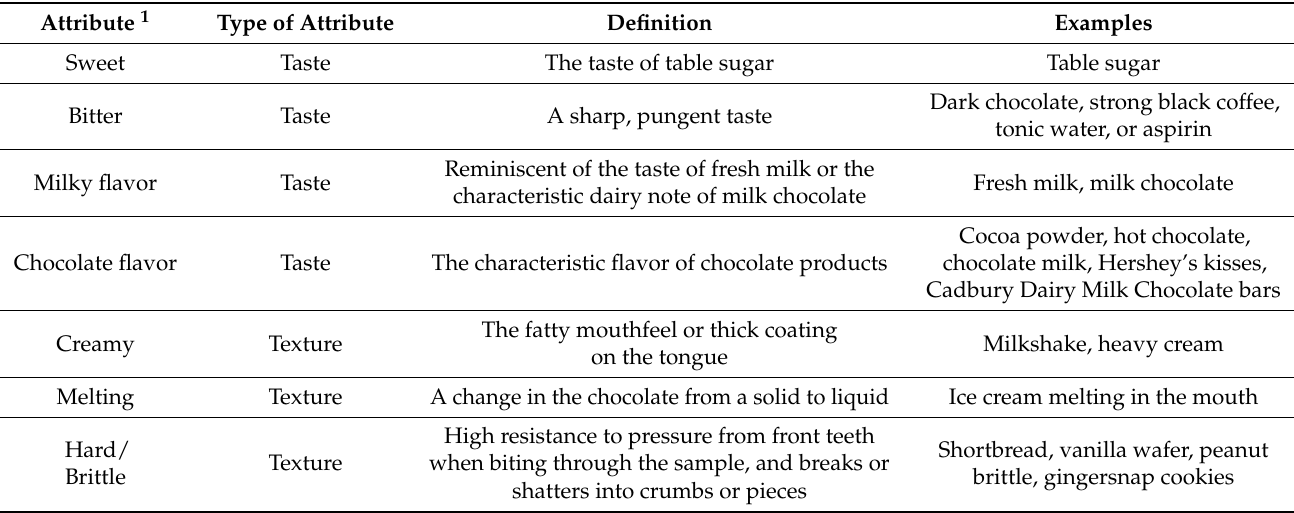
Table 1. Sensory attribute definition list for Temporal Dominance of Sensation (TDS)